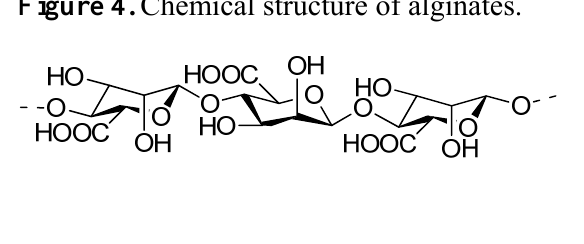
Figure 4. Chemical structure of